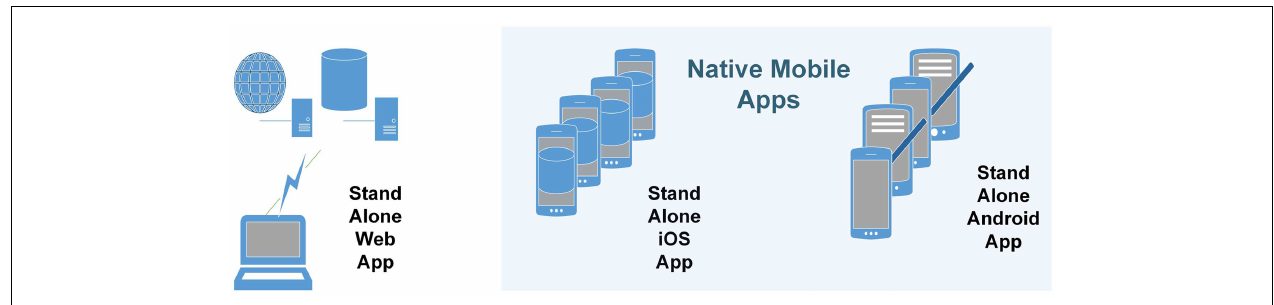
FIGURE 4 | OriginalATLAS infrastructure architecture